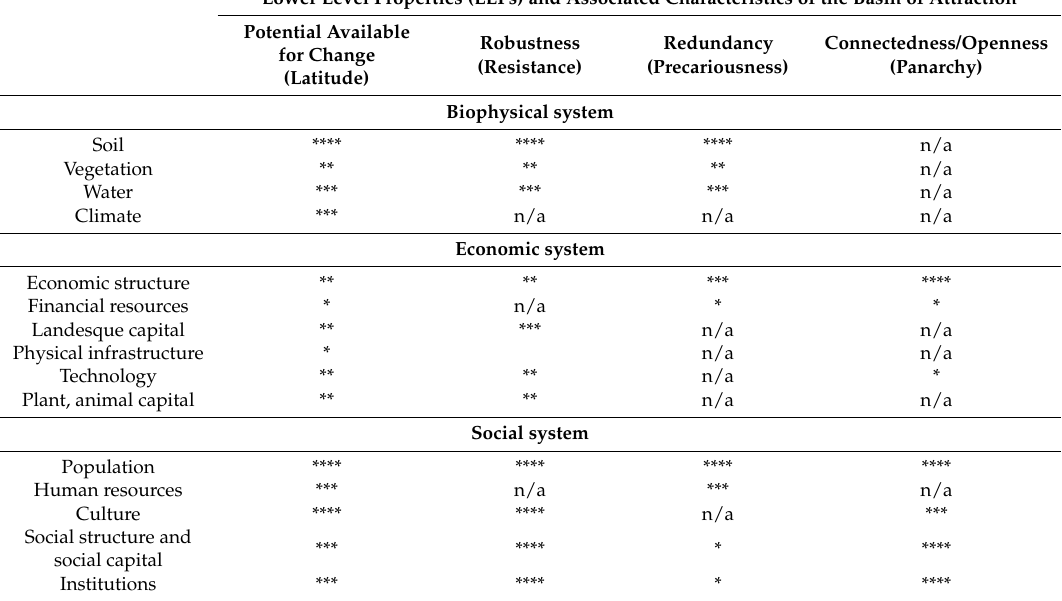
Table 6. Resilience Assessment Matrix (RAM) of the “Cereal modernization phase, 1950–1970”. Lower Level Properties (LLPs) and Associated Characteristics of the Basin of Attraction Potential Available for Change (Latitude)